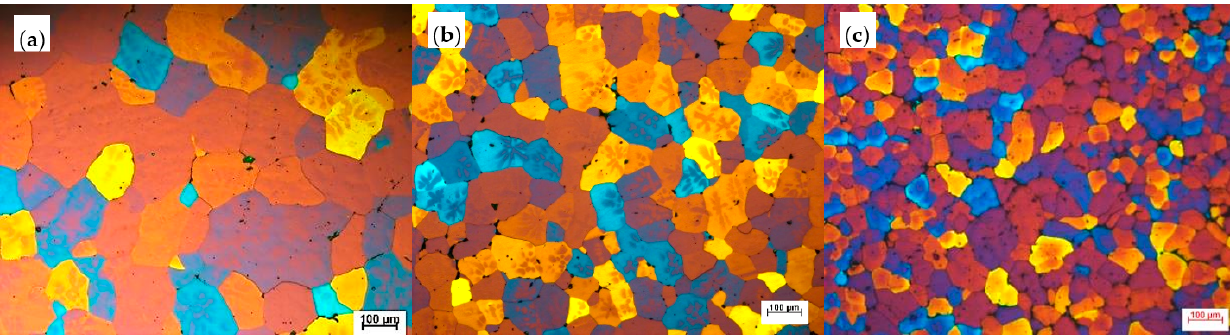
Figure 3. The microstructure of as-cast Al-Mg alloys with different compositions:( a ) alloy 1; ( b ) alloy 2; ( c ) alloy 3.